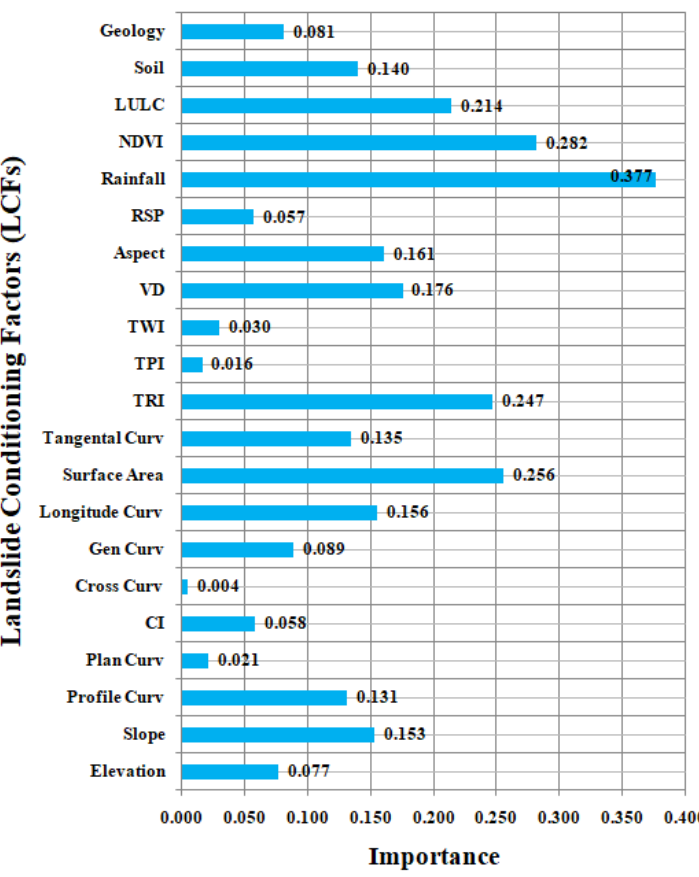
Figure 10. Coefficient values of RR showing the importance of LCFs in LSM.